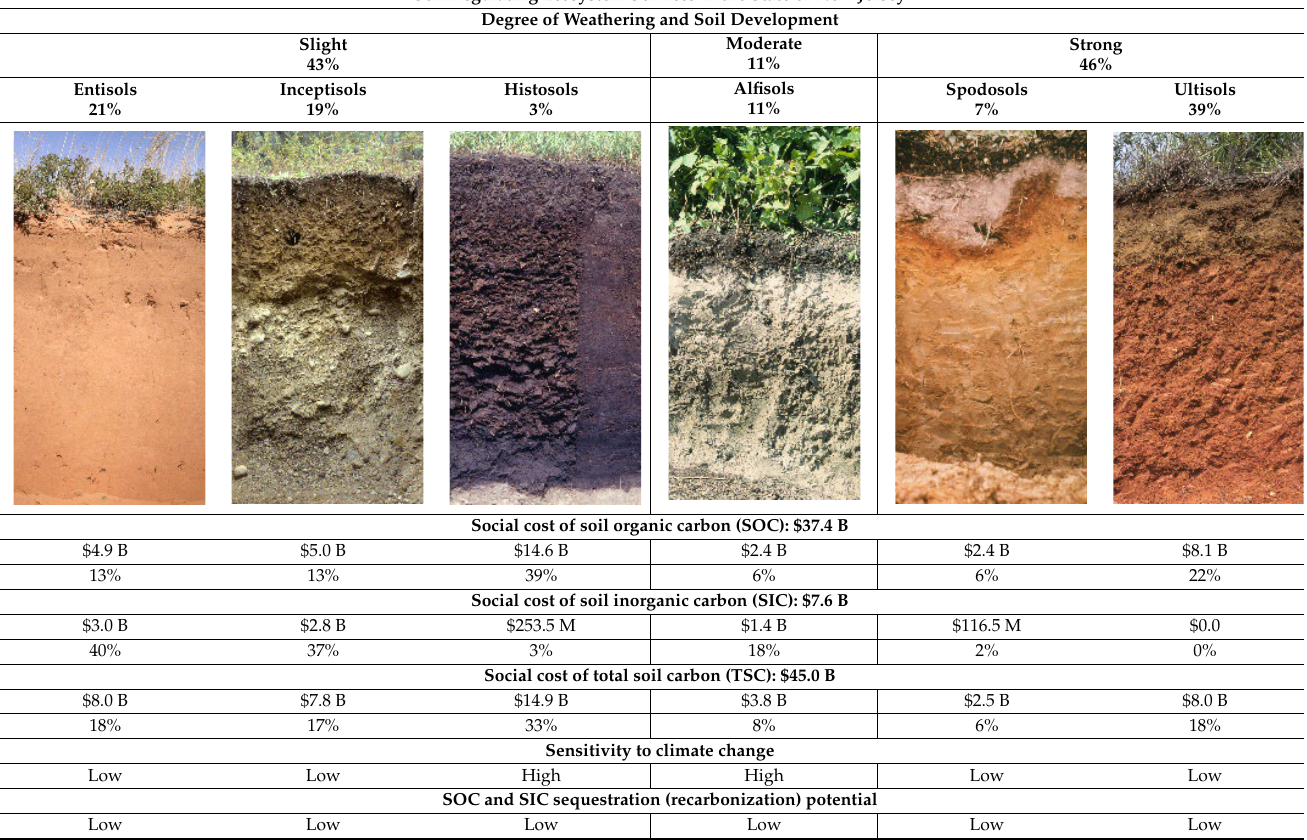
Social cost of soil organic carbon (SOC): $37.4